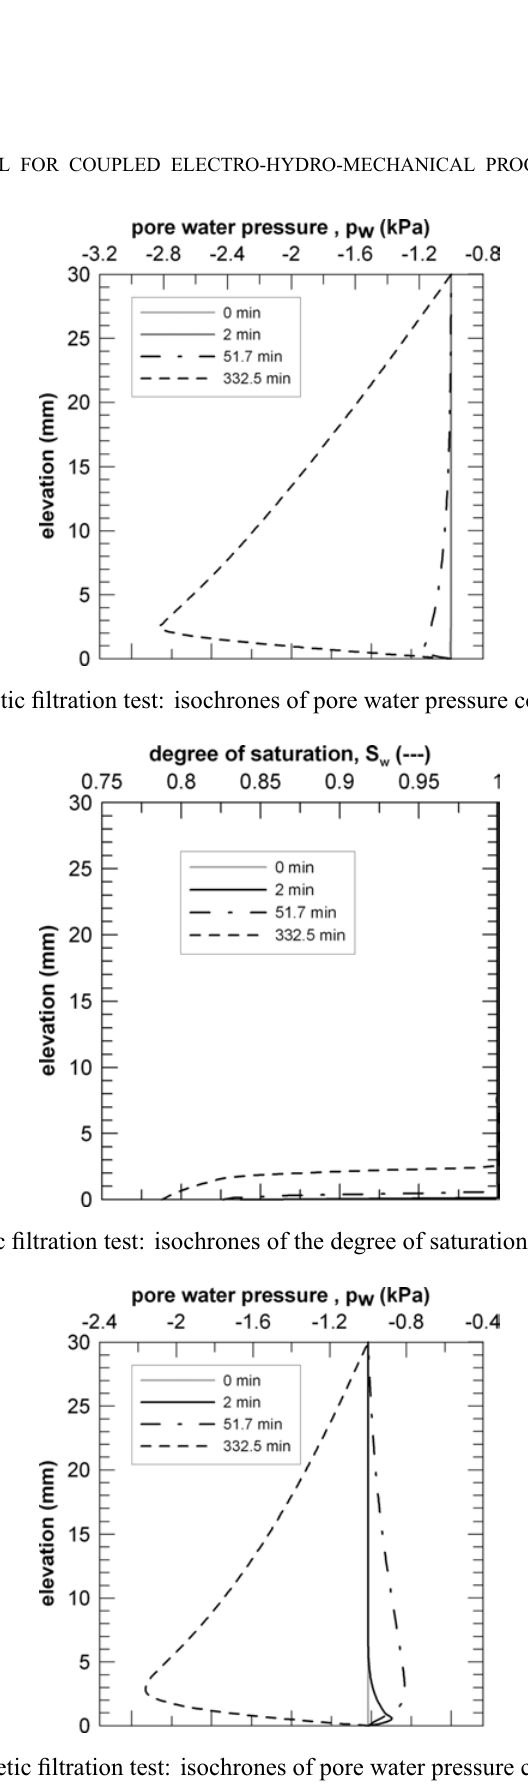
Fig. 10 – Electrokinetic filtration test: isochrones of pore water pressure computed for